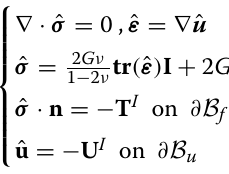
evaluated from Eq. (15), or efficiently approximated by Eq. (19) for plain strain problems or Eq. (23) for 3D